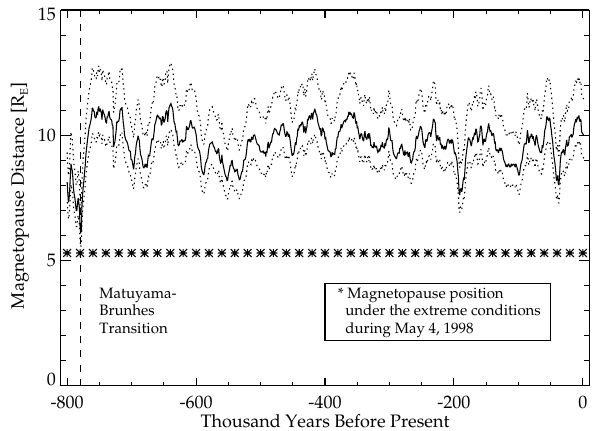
Fig. 2. Estimated magnetopause position during the past 800000 years using the Siscoe and Chen (1975) scaling relation. The error bars indicate the variability of the magnetopause position due to solar wind dynamic pressure variations and have been derived from long-term solar wind flow